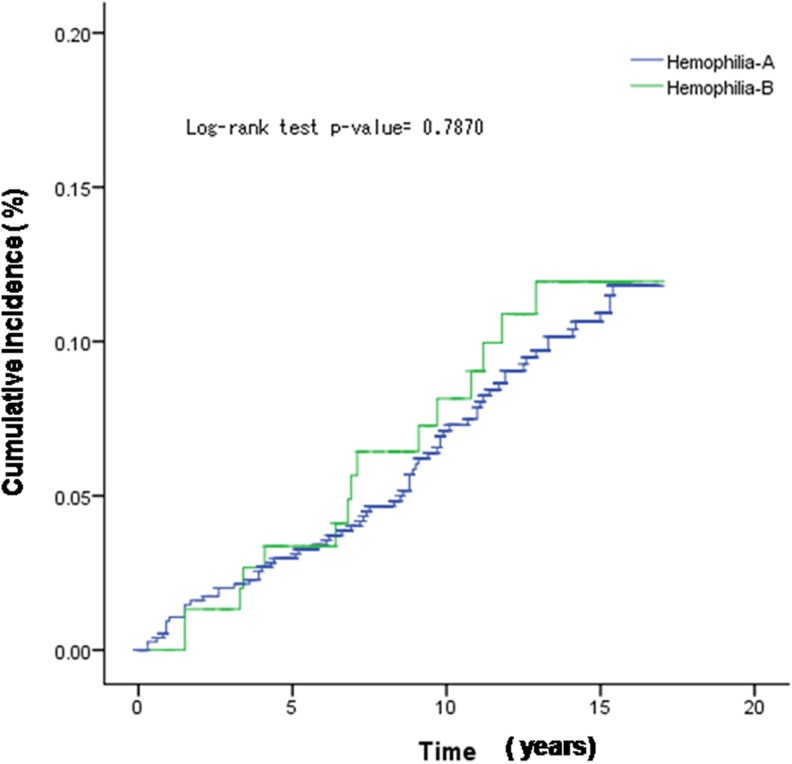
The Kaplan-Meier estimated cumulative incidence of total joint replacement in patients
with hemophila A and hemophilia B.